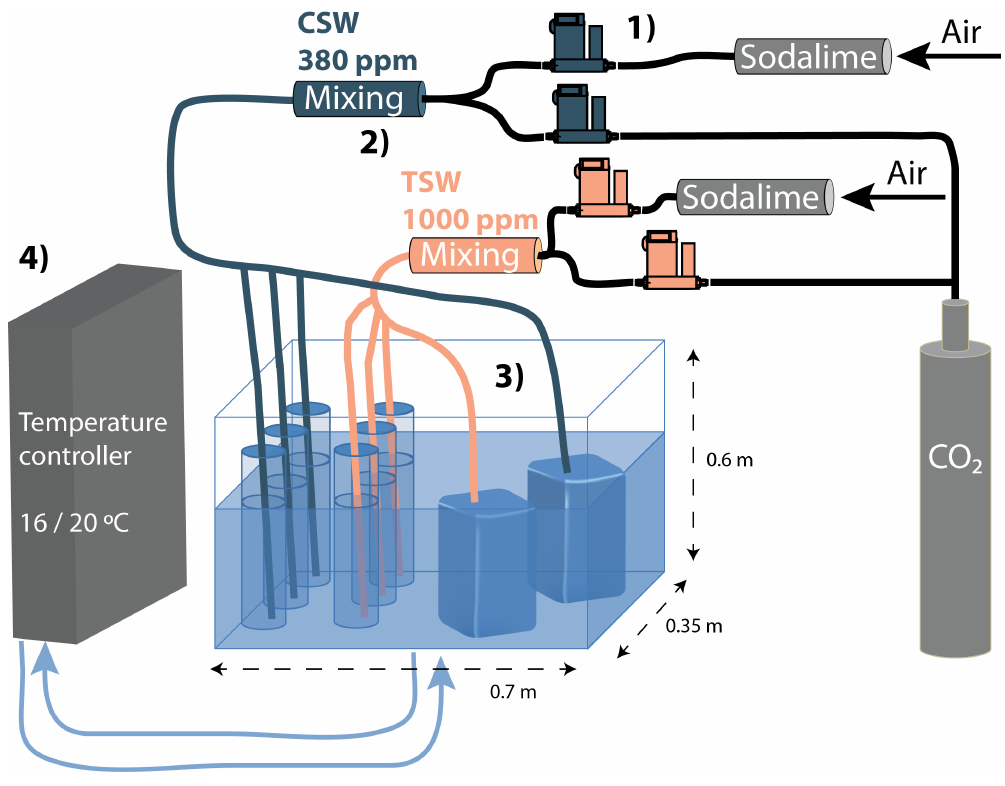
Figure A1. Schematic representation of the setup for the larval development experiment. (1) Ambient air was collected via aquarium pumps and stripped of CO columns; CO gas was obtained from tanks (2) Gasses were mixed in marble filled containers 2 using mass flow controllers to achieve the precise ratio of stripped air and CO p CO concentrations of 380 (control, CSW) and 1000 ppm (treatment, TSW); (3) Three 2 replicate cylinders and one 10 L tank per treatment were bubbled with CO Sensors measuring pH were deployed in two cylinders for each treatment combination; (4) Cylinders were submerged into two separate tanks containing fresh water, which was passed through temperature control units set at 16 ◦ C and 20 ◦ C. See Table 1 for actual experimental temperatures and p CO 2